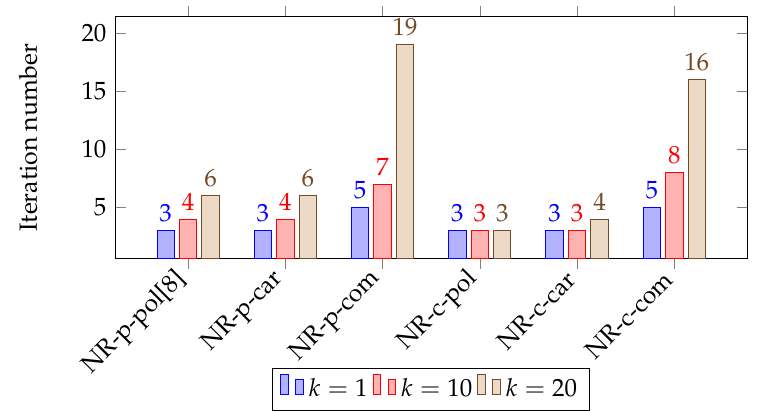
Figure 9. Convergence results for different R / X ratios ( Z = k ∗ R + ıX ) in DCase13.